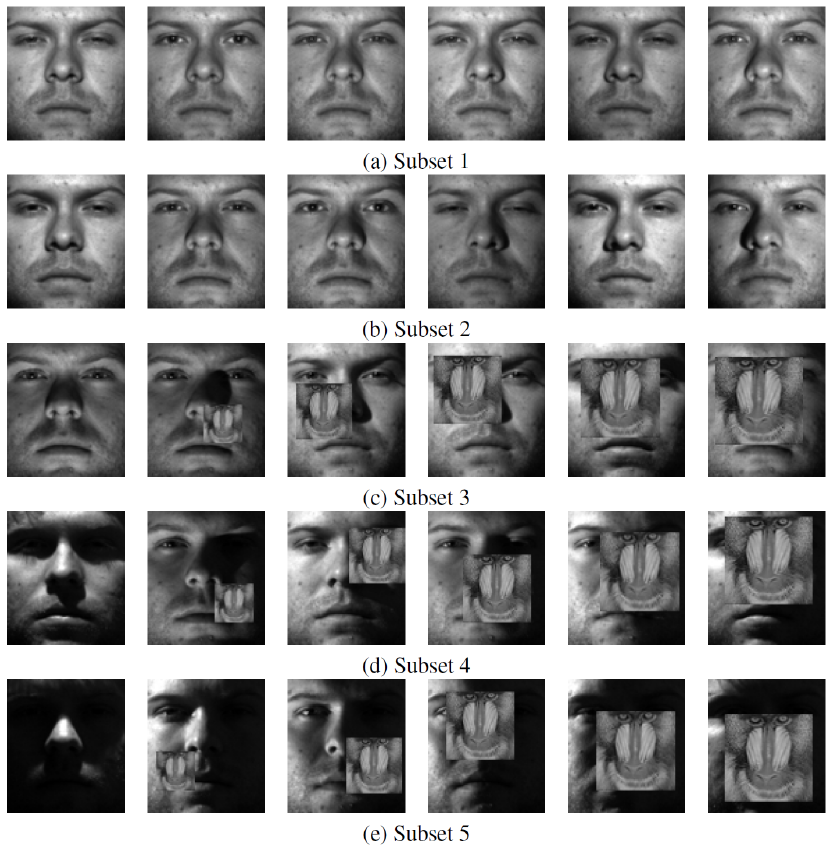
Figure 14. Sample images from the Extended Yale B dataset with randomly located